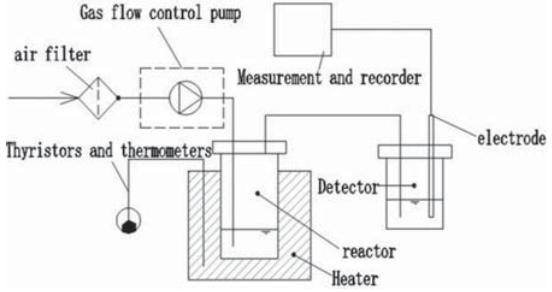
Figure 1: An experimental setup for oxidizing biodiesel.